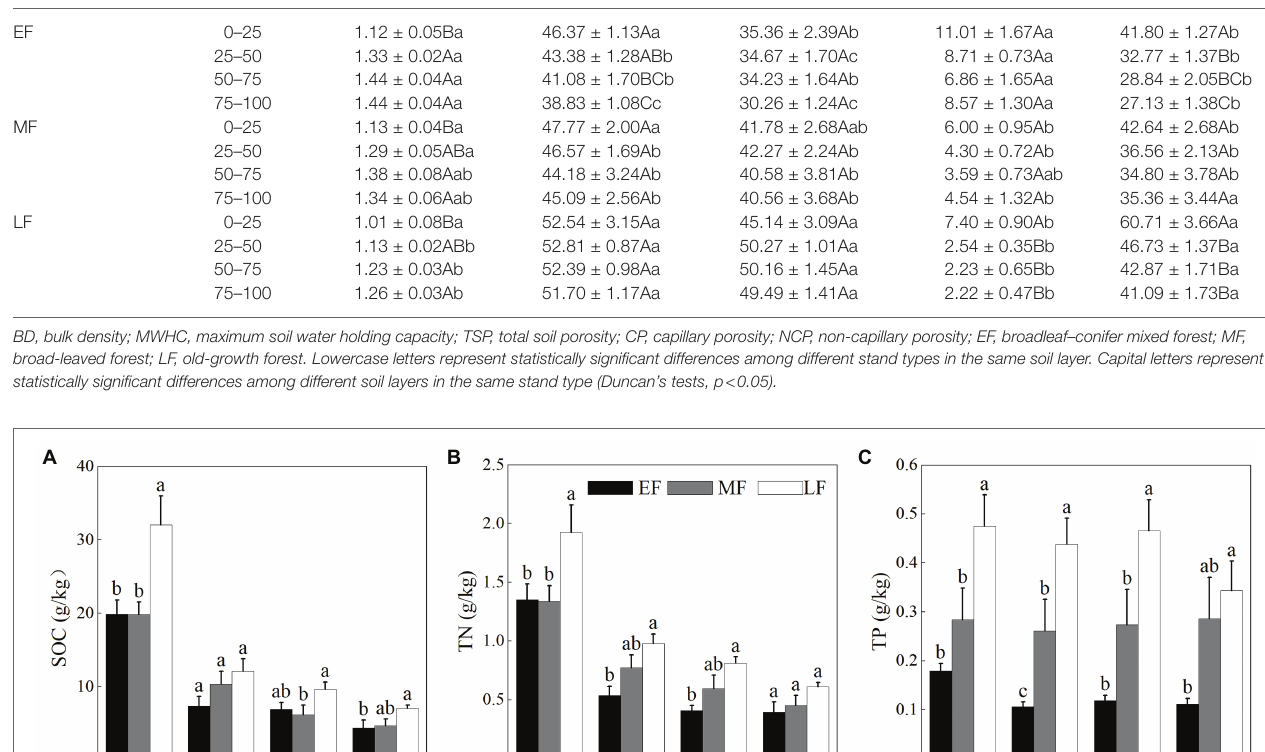
TABLE 1 | The soil’s physical characteristics across the 0–100 depth. Soil layer (cm)